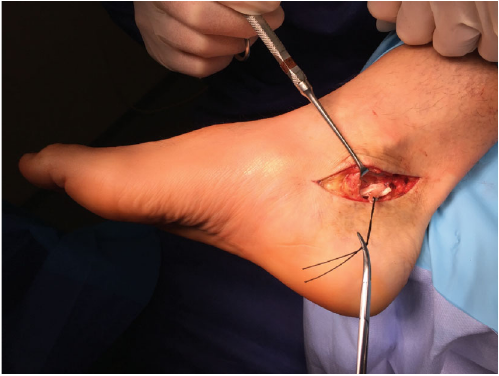
Figure 1: Plantar fl exion deformity in the fi rst and second toes of the right foot.